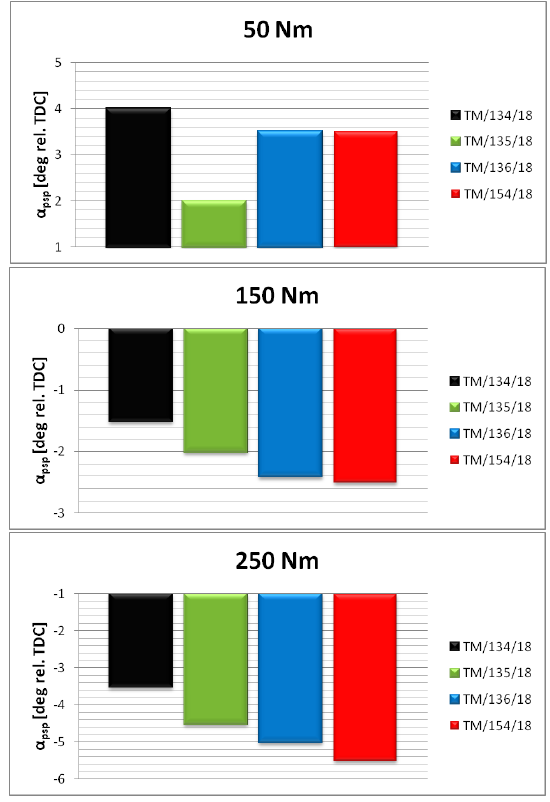
Fig. 2. Start of fuel self-ignition (  psp ) and NO x in the exhaust gas at selected duty points of the engine for the four tested fuels  The TM/136/18 fuel indicates a completely